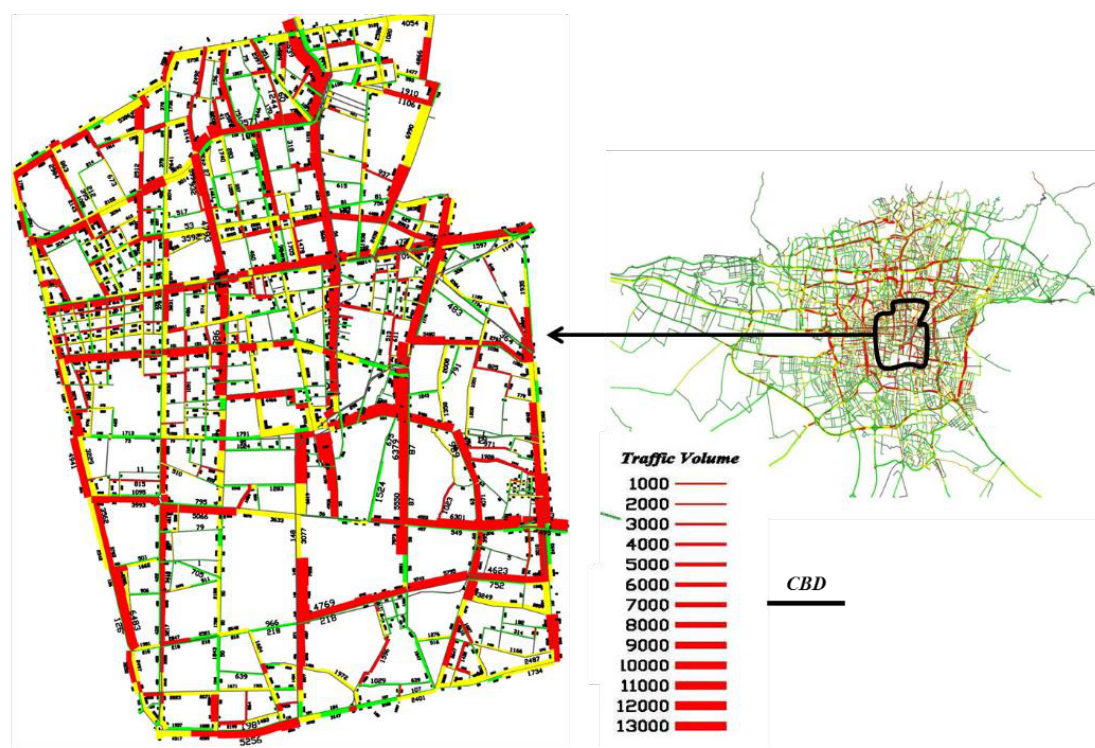
Figure 8: Results of Traffic assignment in EMME Software in alternative A1